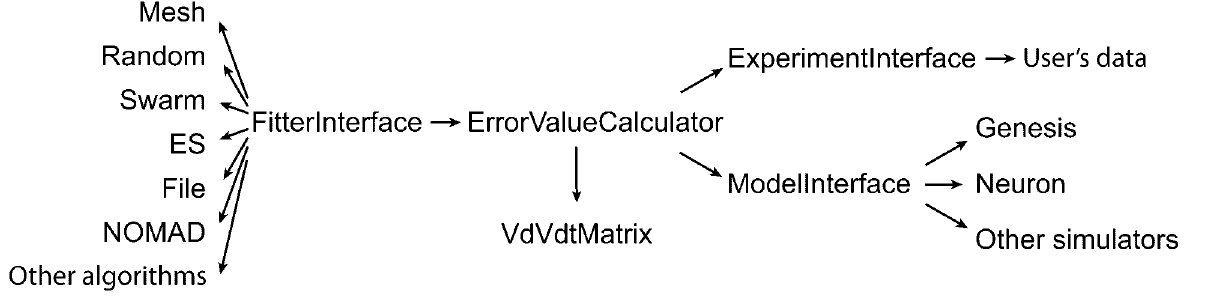
Figure 2. General structure . Schema describing the most important abstract C++ classes implemented in Neurofitter. An arrow represents the relation- ship“makes use